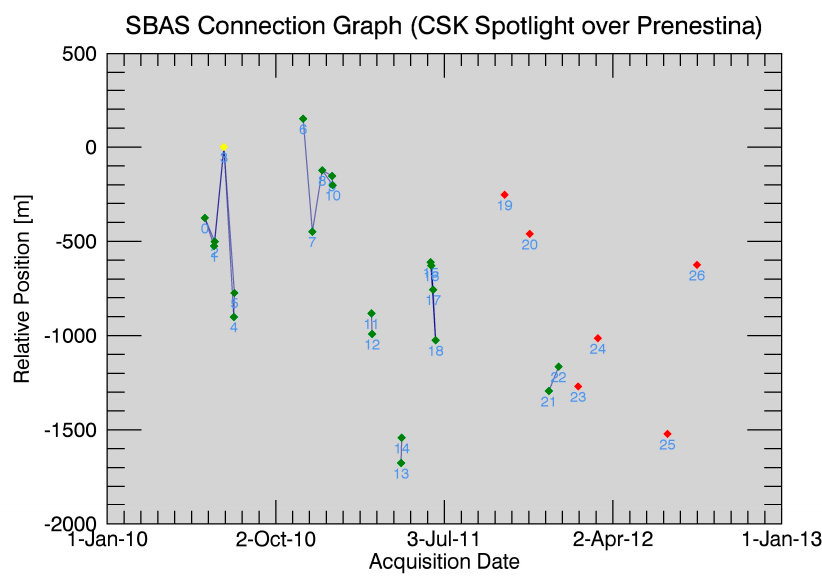
Figure 7. SBAS connection graph for the CSK Spotlight data. Connected pairs are shown that have perpendicular baselines from 0 to 35 percent of the critical baseline, and temporal baselines from 0 to 17 days. Disconnected blocks are permitted given that displacement velocities are not required to be calculated. Selected and discarded images are displayed respectively as green and red points. The yellow point shows the super master image.